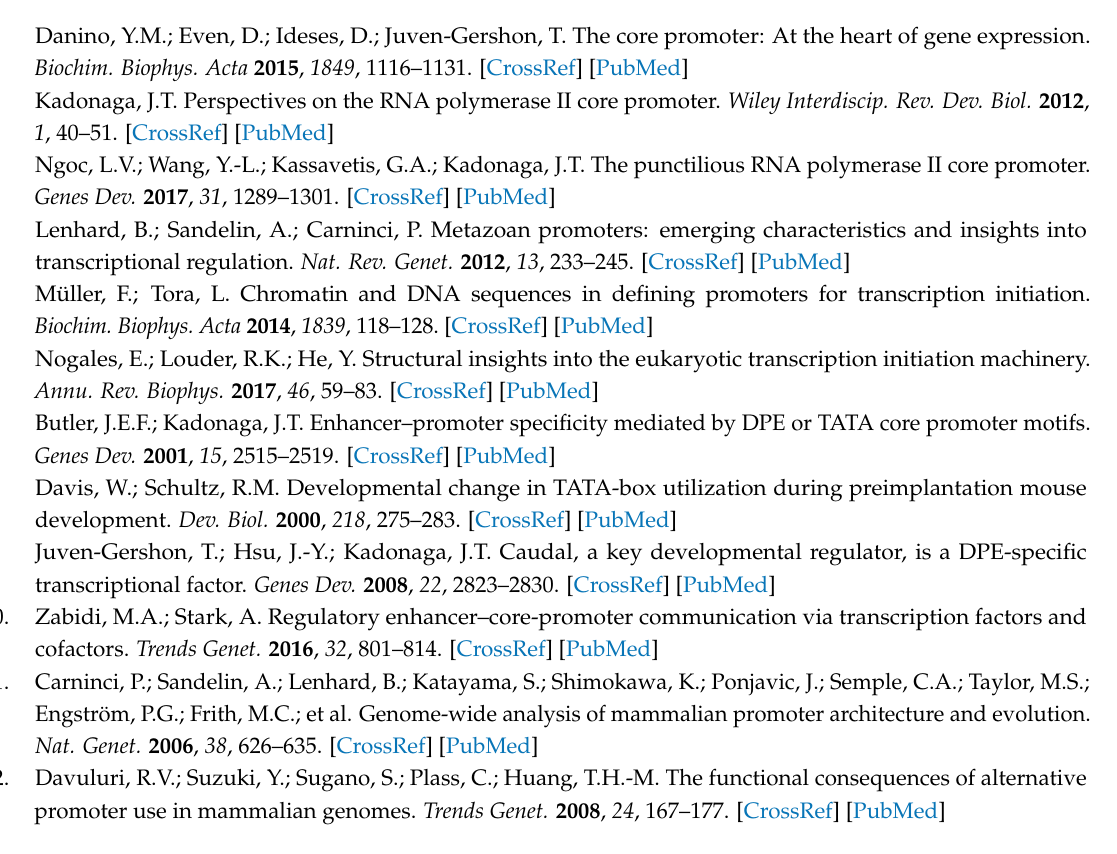
s1. Figure S1: Effect of cell differentiation on total MYC expression, Figure S2: Effect of LiCl mediate Wnt activation on MYC mRNA in HCT-116 cells, Figure S3: Activity of MYC’s promoters by luciferase assay, Figure S4: Enhancer deletions information and results of Sanger Sequencing, Figure S5: Growth curves of single enhancer deleted clonal lines, Figure S6: Conservation of core promoter elements in MYC promoters, Figure S7: Effect of core promoter mutants on P2 basal activity and fold activation, Figure S8: Influence of INR and DPE on P1 promoter maximum promoter activity, Table S1: Oligonucleotides used to generate promoter reporter assays and mutants, Table S2: Primers for RT-PCR, Table S3: Primers used to generate px330 plasmids, Annex S1: MYC reporter plasmids, Annex S2: Sequences of the promoter